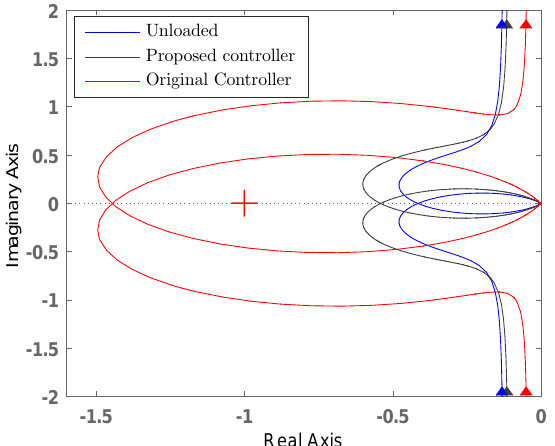
Figure 11. Comparing the Nyquist diagrams of LRC’s loop gain at full load with and without the proposed controller, highlighting its stabilizing and performance preserving